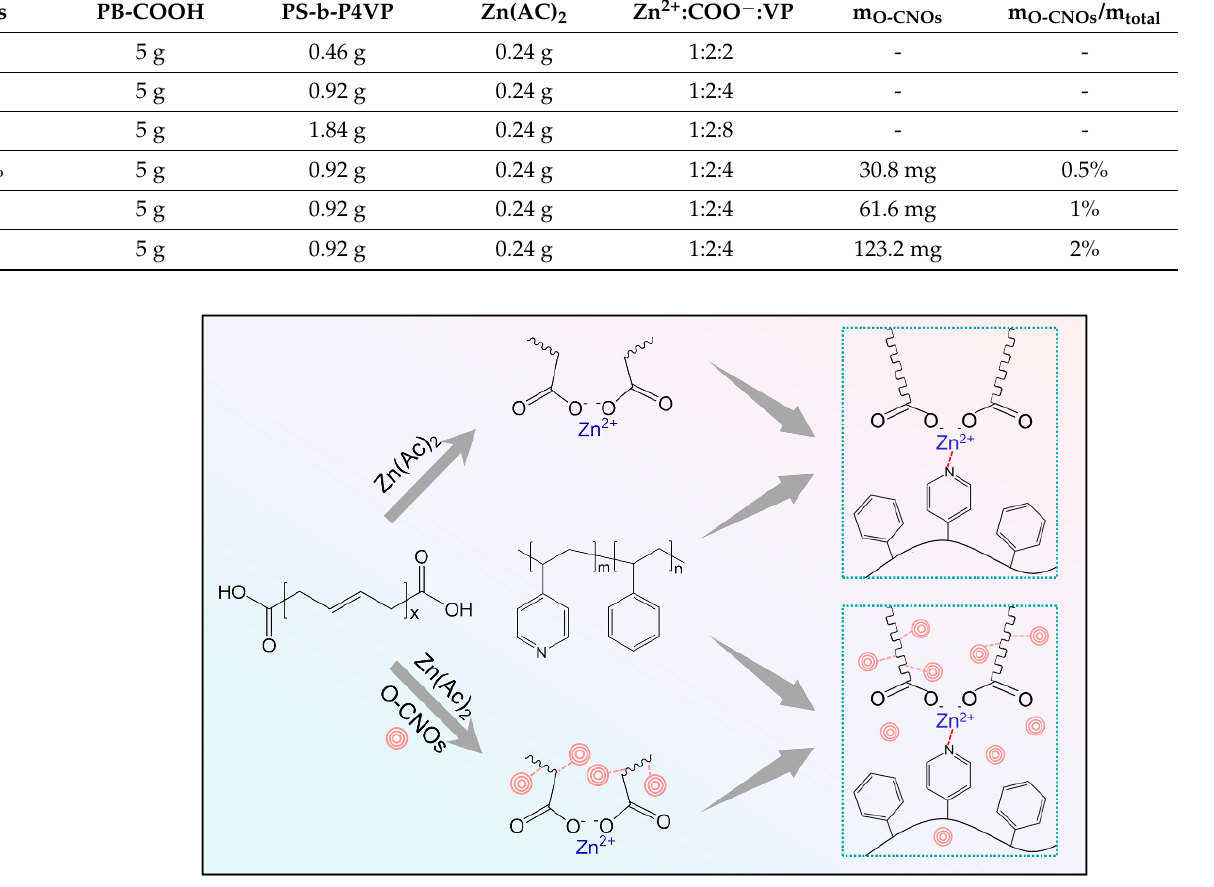
Figure 1. Schematic diagram of the preparation process of self-healing polybutadiene rubber composite without or with O-CNOs.